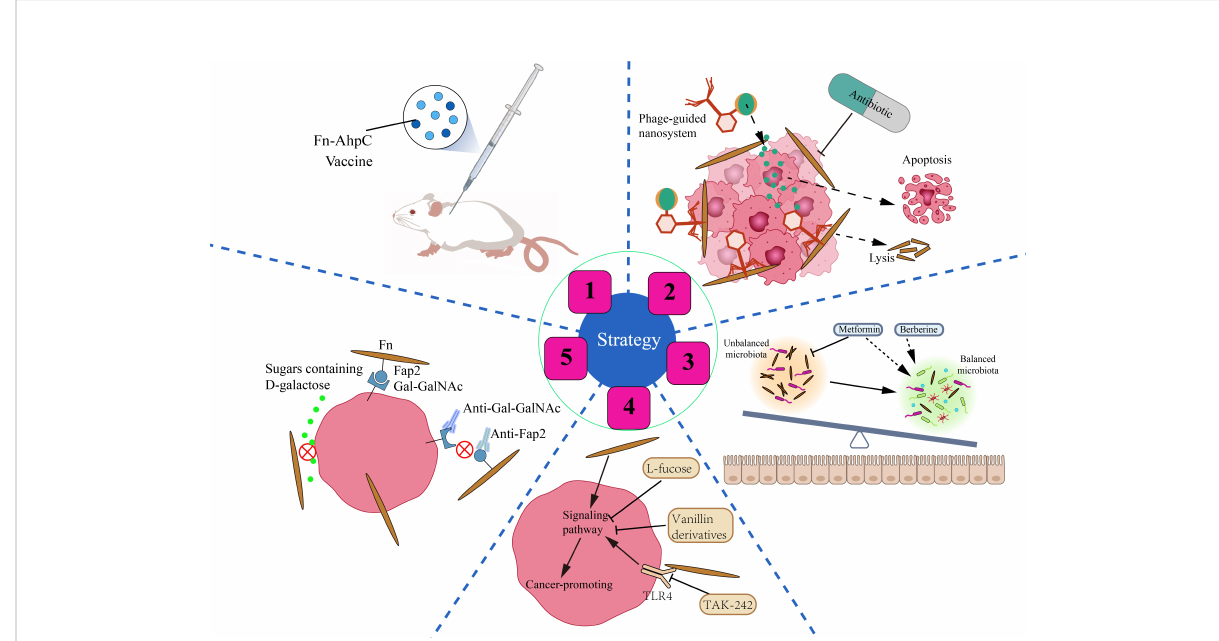
FIGURE 4 Strategies for CRC prevention and treatment by anti-Fn. 1: Prevention of Fn infection. Fn derived vaccine enhances the immunity of mice to Fn infection. 2: Inhibition/Elimination of intratumoral Fn. Antibiotics can signi fi cantly reduce the intratumoral Fn load. Phage guided nano system with drug can kill two birds with one stone in CRC. 3: Rebalance of gut microbiota. Some non-antibiotic drugs such as berberine and metformin can not only inhibit Fn but also improve gut fl ora. 4: Reverse Fn-activated signaling. A small part of compounds and molecular inhibitors such as L-fucose, vanillin derivatives, TAK-242 can selectively inhibit the Fn activated oncogenic signaling pathway. 5: Blockade of Fn ’ s cell adhesion and internalization. Antibodies such as antibodies targeting Gal-GalNAc or Fap2 and sugars such as D-galactose can block the adhesion of Fn to CRC cells, and eliminate the malignant effect of Fn from the